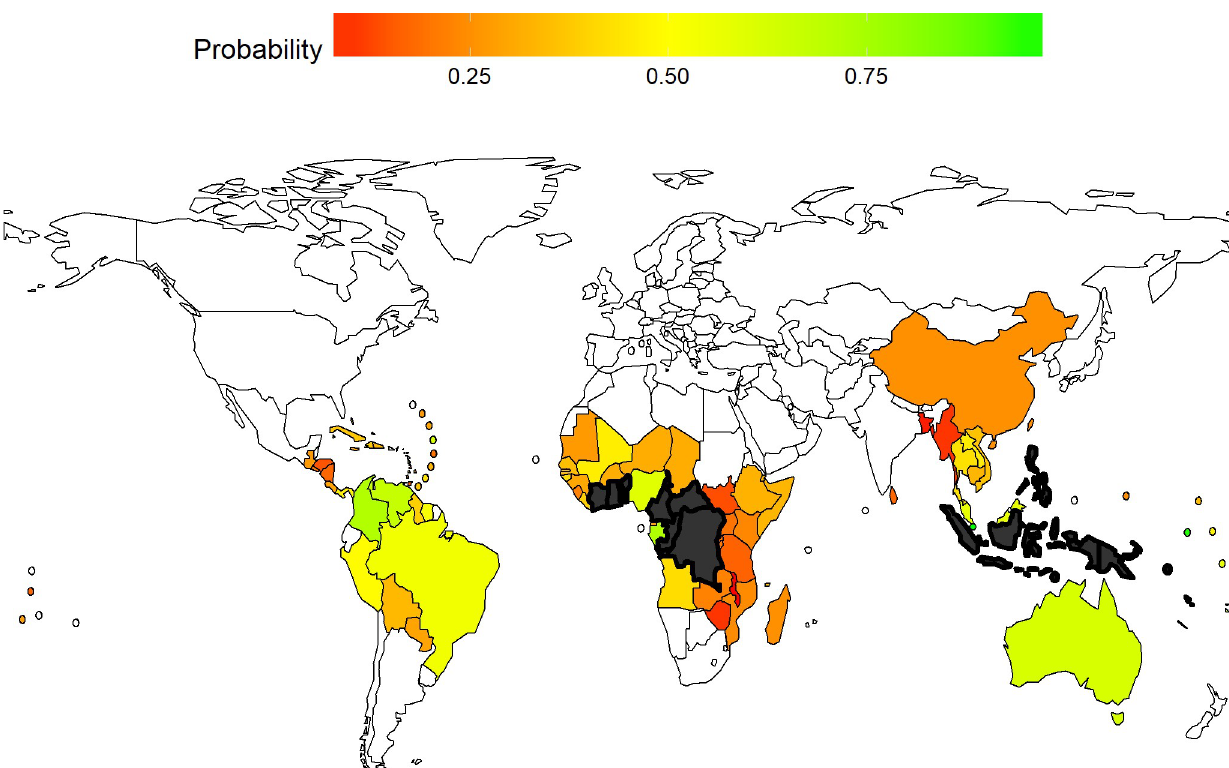
Fig 4. Predicted probability of case reporting in previously endemic countries (current status unknown) conditional on ongoing transmission, three year period ending 2015. Currently endemic countries (current status known) are depicted in grey. In addition to Member States, there are 9 countries or areas with a history of yaws for which data are not included in this map: British Virgin Islands, Guadeloupe, French Guiana, Guam, Montserrat, Martinique, New Caledonia, Puerto Rico, and Wallis and Futuna. Created using R and World Health Organization shapefiles under Creative Commons license